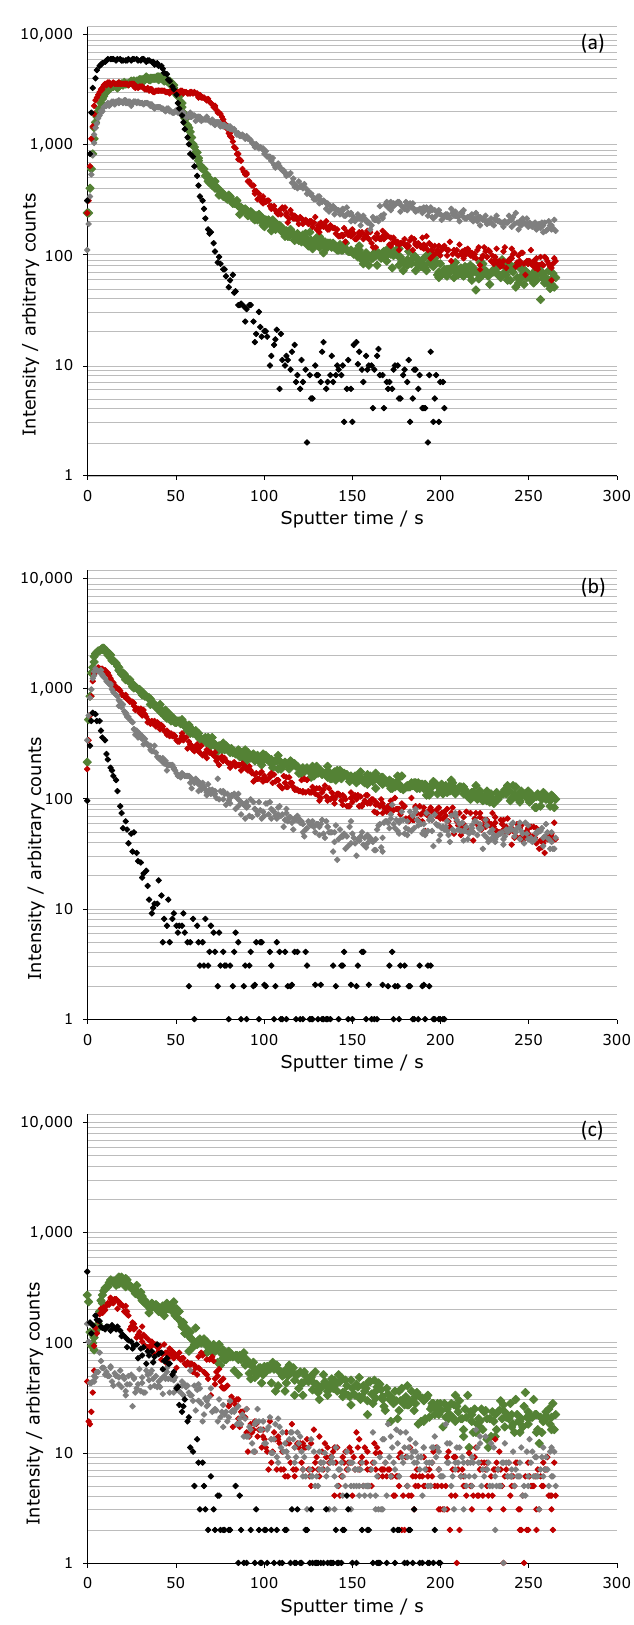
Figure 6. ToF–SIMS depth profiles for the BW surfaces, showing the change in ion intensity over time for (a) 54 FeO − , (b) BO − and (c) Fe − . The colours correspond to the ionic liquid used PBOB (green), and PBScB 2 2 B 3 O 3 (red), with the untreated surface shown separately (grey). The untreated PD surface is also shown